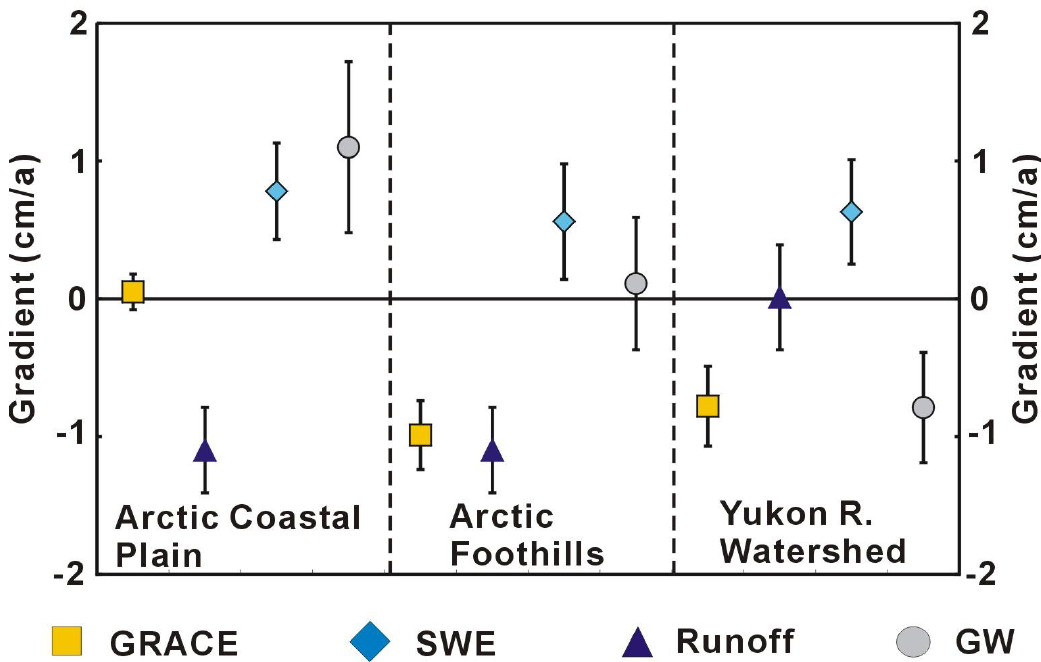
Figure 4. Regionalized gradients and uncertainties from GRACE, SSM/I and runoff, with estimated groundwater storage change: (a) volume change rates and (b) area-average thickness change. The scale on the left pertains to the Arctic coastal plain and foothills and right side pertains to the Yukon River